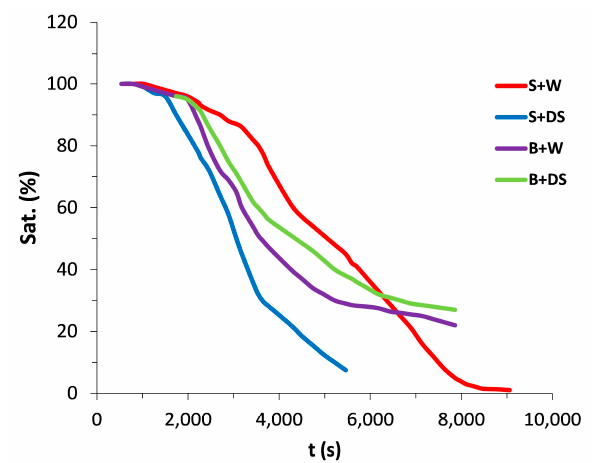
Figure 16. Saturation of the porous media corresponding to the state of dryout prior to the replenishment.